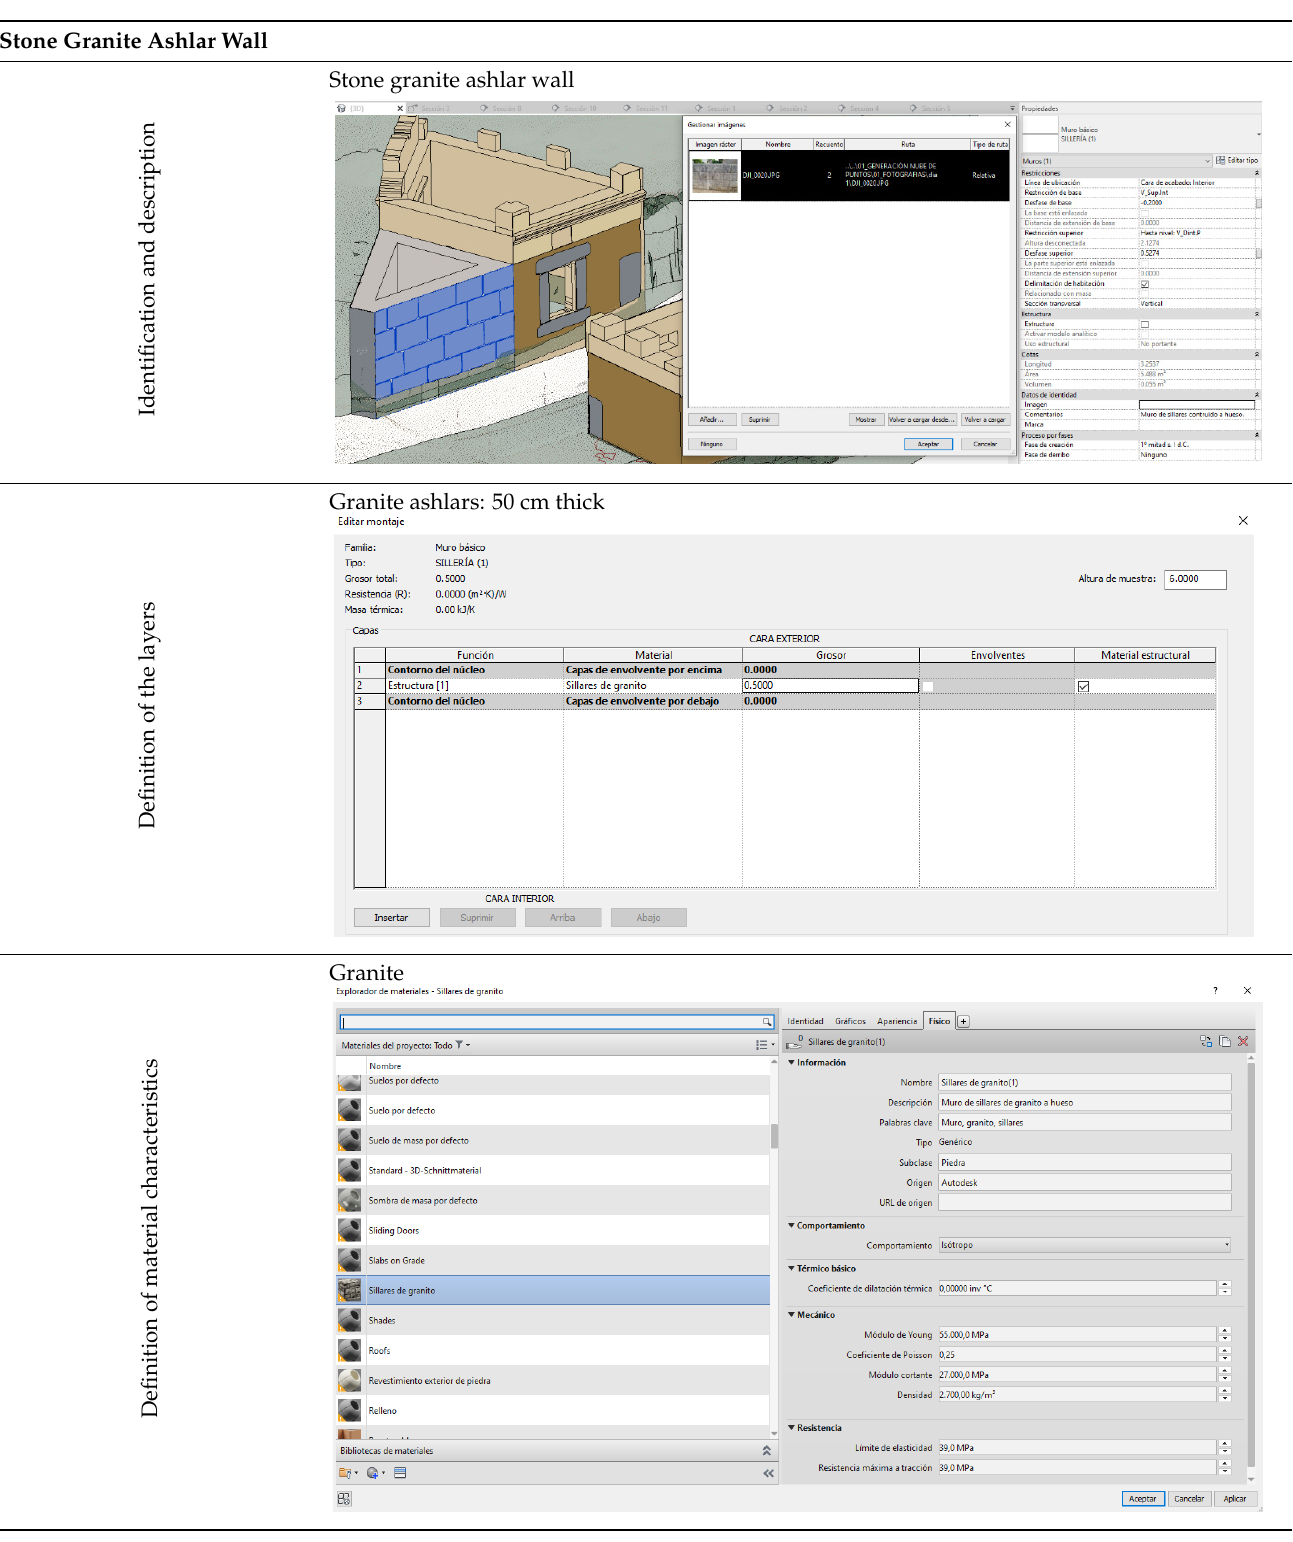
Table 8. Example of characterization of construction elements, in this case, of a wall of granite ashlars.